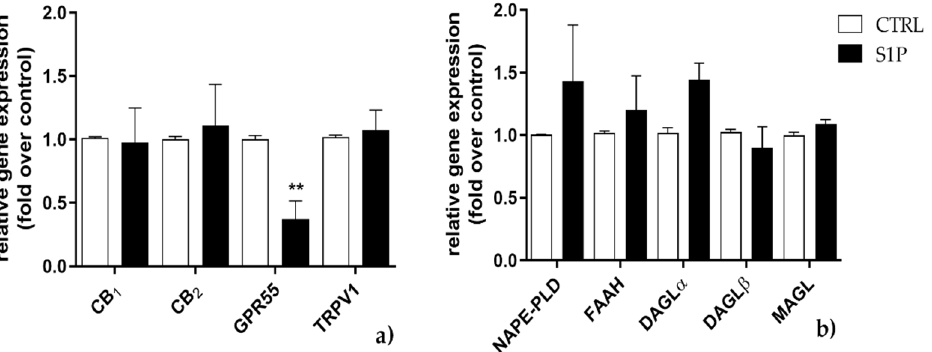
Figure 2. Effect of S1P on mRNA expression of endocannabinoid (eCB)-binding receptors ( a ) and metabolic enzymes ( b ) at 48 h. C2C12 cells were left untreated (in white) or were treated for 48 h with 1 µ M of S1P (in black). The values are expressed as 2 ( − ∆∆ Ct ) and normalized to β -Actin and GAPDH. Data are presented as means ± SEM ( n = 5). Statistical analysis was performed by TWO- WAY ANOVA test followed by Bonferroni post hoc test. [** p < 0.01 vs. control cells (CTRL)]. Then, the protein expression of eCB-binding receptors, AEA and 2-AG metabolic enzymes was evaluated by Western blot in C2C12 cells treated with 1 μ M S1P for 24 h. In